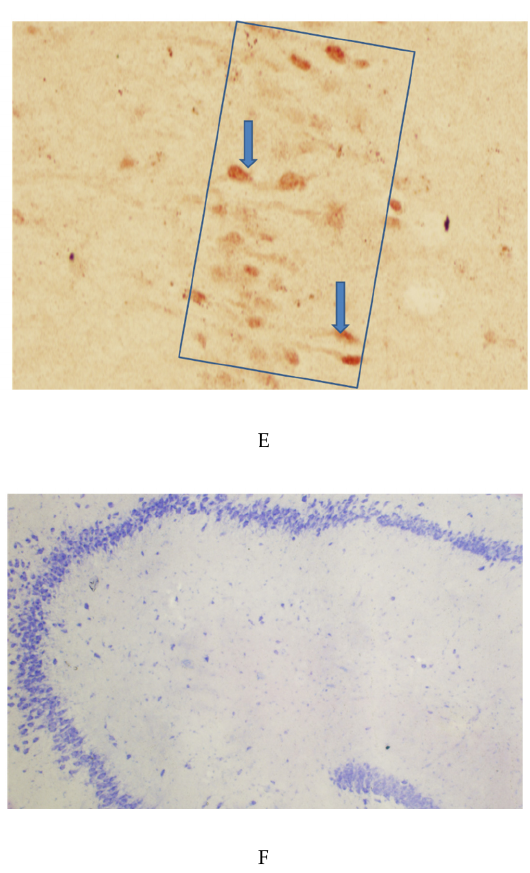
Figure 2. ( A ) HIV-1TGR coronal section of the hippocampus stained with hematoxylin and eosin. This image of the 10-micron thick section was taken at 4 × . In the present section, the box encloses the hippocampal areas where both normal neurons and degenerating neurons could be found. The Blue arrow points to the granular cell layer where degenerating neurons could be found. See also Figure 2C. ( B ) HIV-1TGR coronal section of the hippocampus stained with hematoxylin and eosin. This image of the 10-micron thick section was taken at 60 × . The H&E stain shows signs of nuclear atypia, consistent with neuronal degeneration. The degenerating neurons were very infrequent, but they could be found in di ff erent areas of the hippocampus, like CA3 and the dentate gyrus. Arrows point to several examples. This degeneration was confirmed with CSD (see also Figure 2C). ( C ) The HIV-1TGR coronal section of the hippocampus is stained with cupric silver stains (CSS) and counterstained with neutral red. This image of the 75-micron thick section was taken at 20 × . The box encloses the area of granular neurons, which appear lightly stained with neutral red. One hippocampal neuron is labeled with the CS stain and reveals its hippocampal morphology. High power further demonstrates the morphology in Figure 2D. ( D ) HIV-1 TGR, original magnification 60 × CSS with neutral red counterstain. Degenerating neurons in CA3 could be identified in the granular layer. The box outlines the dentate gyrus granular cell layer, and the arrows point to degenerating cells and their processes. ( E ) Immunocytochemistry of CXCR4 in the HIV-TGR hippocampus. Original magnification 40 × . DAB brown chromogen was used. Positive-staining neurons could be found throughout the hippocampus. The box shows the area of the dentate granular cells. It can be seen that many of this cell type was labeled for CXCR4. Arrows point to several examples. ( F ) Negative control for CXCR4 immunocytochemistry in the hippocampus of the HIV-1 TG rat. Original magnification 4 × . As there was a lack of specific staining, hematoxylin was used to demonstrate the presence of the cells. Nonspecific staining was not detected with the omission of the immune